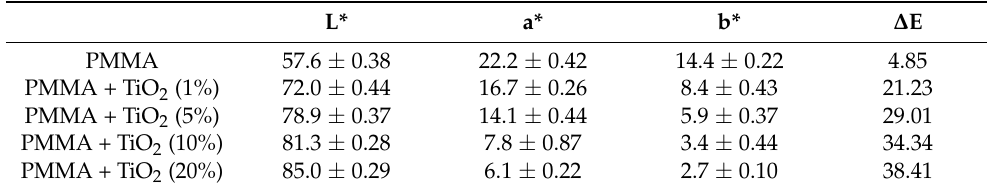
Table 2. CIE L*, a*, b* color parameters of PMMA and its TiO 2